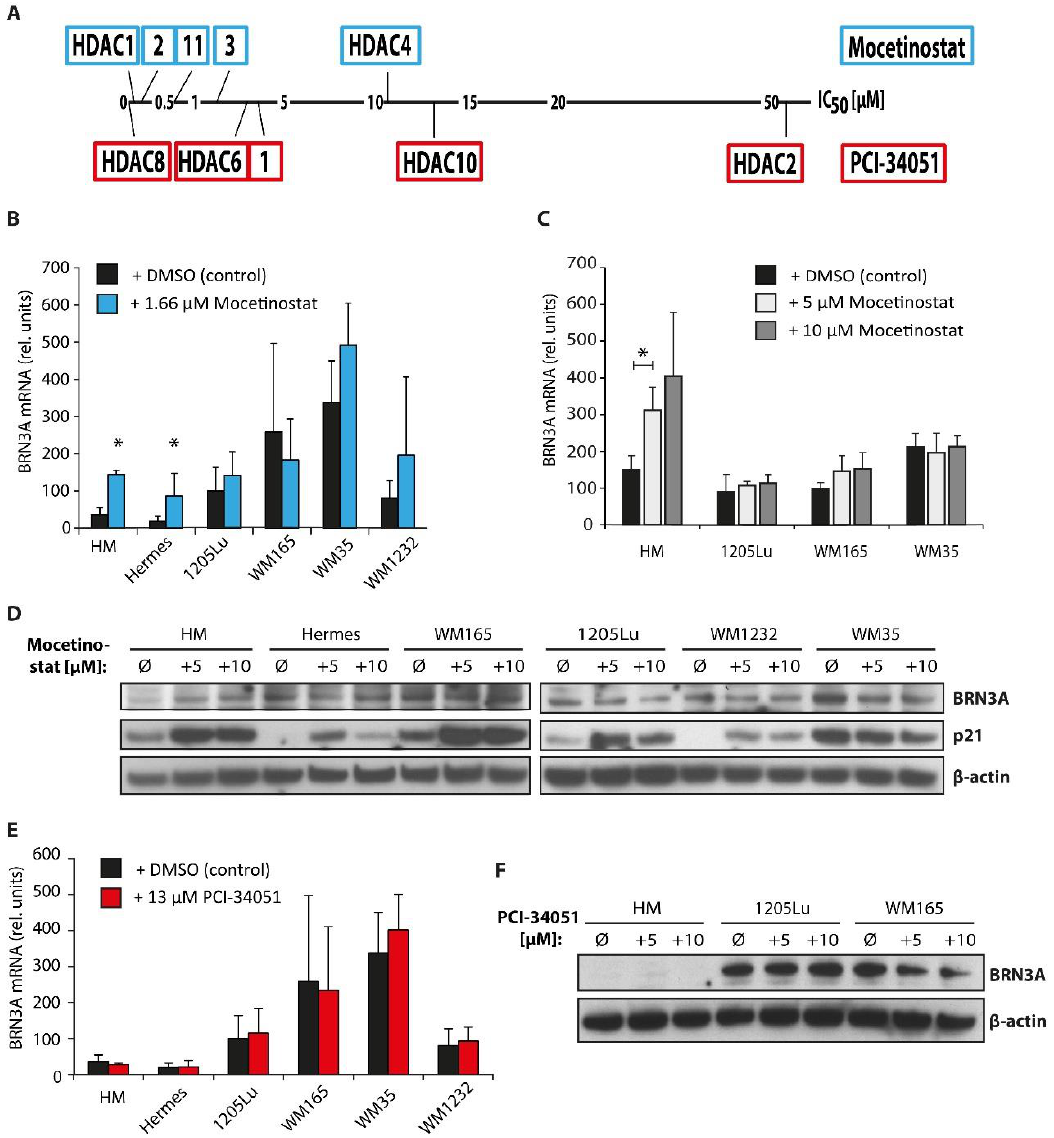
Figure 4. Inhibition of class I HDACs induced BRN3A expression in melanocytes. ( A ) Schematic overview of IC50 values of selective HDAC inhibitors mocetinostat (blue box) and PCI-34051 (red box) for different HDACs. In concentrations below 20 µM, mocetinostat inhibits HDAC1, 2, 3, and 11, whereas PCI-34051 inhibits HDAC1, 6, 8, and 10 [32,33]. ( B ) Relative BRN3A gene expression levels in melanocytes (HM, Hermes) and melanoma cells after treatment with 1.66 µM mocetinostat or DMSO (control) for 6 h, n = 3. *: p < 0.05 vs. corresponding DMSO control. ( C ) Relative BRN3A gene expression levels in melanocytes and melanoma cells after treatment with 5 µM or 10 µM mocetinostat or DMSO (control) for 6 h, n = 3. *: p < 0.05 vs. corresponding DMSO control. ( D ) BRN3A protein expression in melanocytes (HM, Hermes) and melanoma cells after treatment with 5 µM (+ 5) and 10 µM (+ 10) mocetinostat for 24 h. Ø : DMSO (control), representative immunoblot. ( E ) Relative BRN3A gene expression levels in melanocytes (HM, Hermes) and melanoma cells after treatment with 13 µM PCI-34051 or DMSO (control) for 6 h, n = 3. ( F ) BRN3A protein expression in HM and melanoma cells after treatment with 5 µM (+ 5) and 10 µM (+ 10) PCI-34051 for 24 h. Ø : DMSO (control); one representative immunoblot is shown. 2.5. HDAC2 Is a Key Epigenetic Regulator of BRN3A in Melanocytes Basal protein expression levels of BRN3A, as well as HDAC1, HDAC2, HDAC3, and HDAC11, which were inhibited by mocetinostat were determined (Figure 5A).